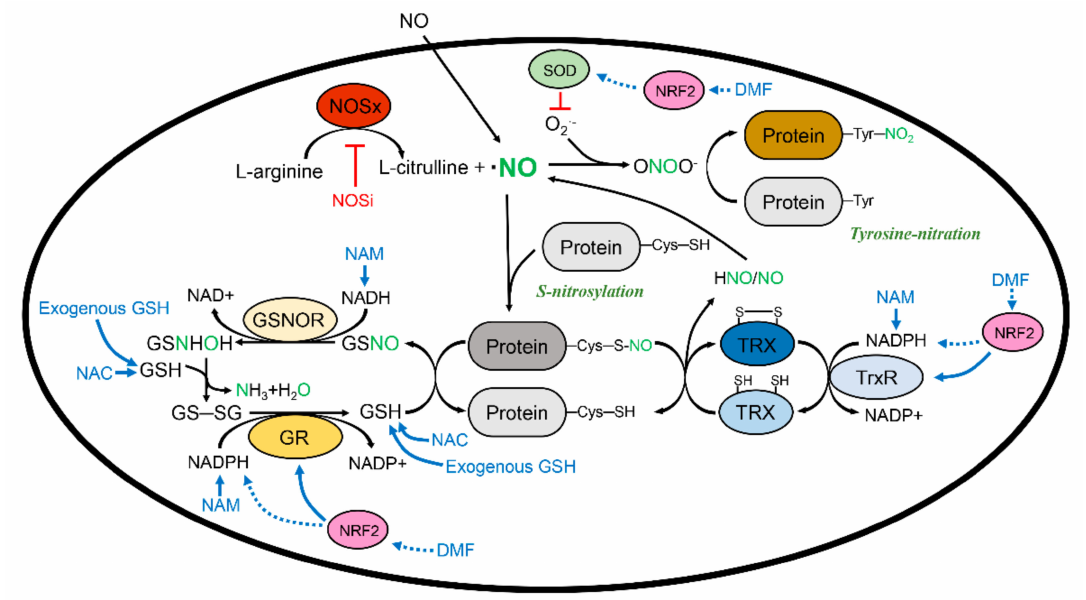
Figure 2. Schematic demonstration of the nitrosation and endogenous reducing system. Blue arrow: direct activation; dashed arrow: indirect activation; red blunted line: inhibition. Cys, cysteine; DMF, dimethyl fumarate; GR, glutathione reduc- tase; GSH ( γ -l-glutamyl-l-cysteinyl-glycine), glutathione; GSNHOH, N-hydroxysulfinamide; GSNO, S-nitrosoglutathione; GSNOR, S-nitrosoglutathione reductase; GSSG, glutathione disulfide; GSSOH, glutathione sulfinic acid; HNO, nitroxyl; NAC, N-acetyl-L-cysteine; NADH, nicotinamide adenine phosphate; NADPH, nicotinamide adenine dinucleotide phos- phate; NAM, nicotinamide; NO, nitric oxide; NOS, nitric oxide synthase; NOSi, NOS inhibitor; NRF2, nuclear factor erythroid 2-related factor 2; ROS, reactive oxygen species; SOD, superoxide dismutase; TRX, thioredoxin; TrxR, thioredoxin reductase; Tyr,